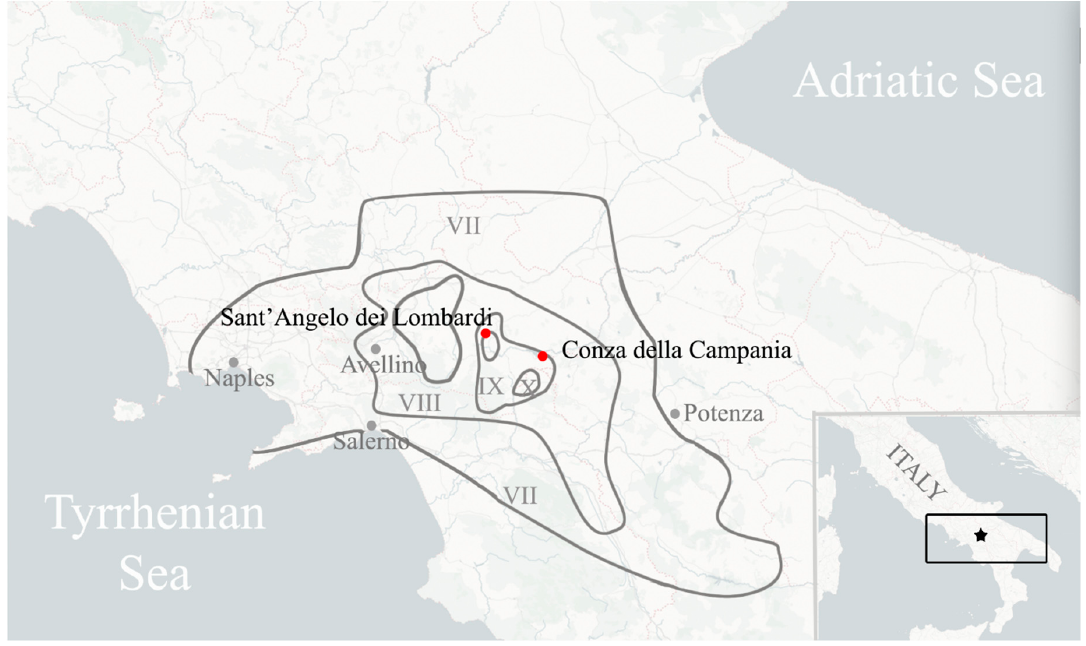
Figure 1. Isoseismal lines of the 1980 earthquake and localization of the two studied towns (modified after Postpischl et al. [13]).